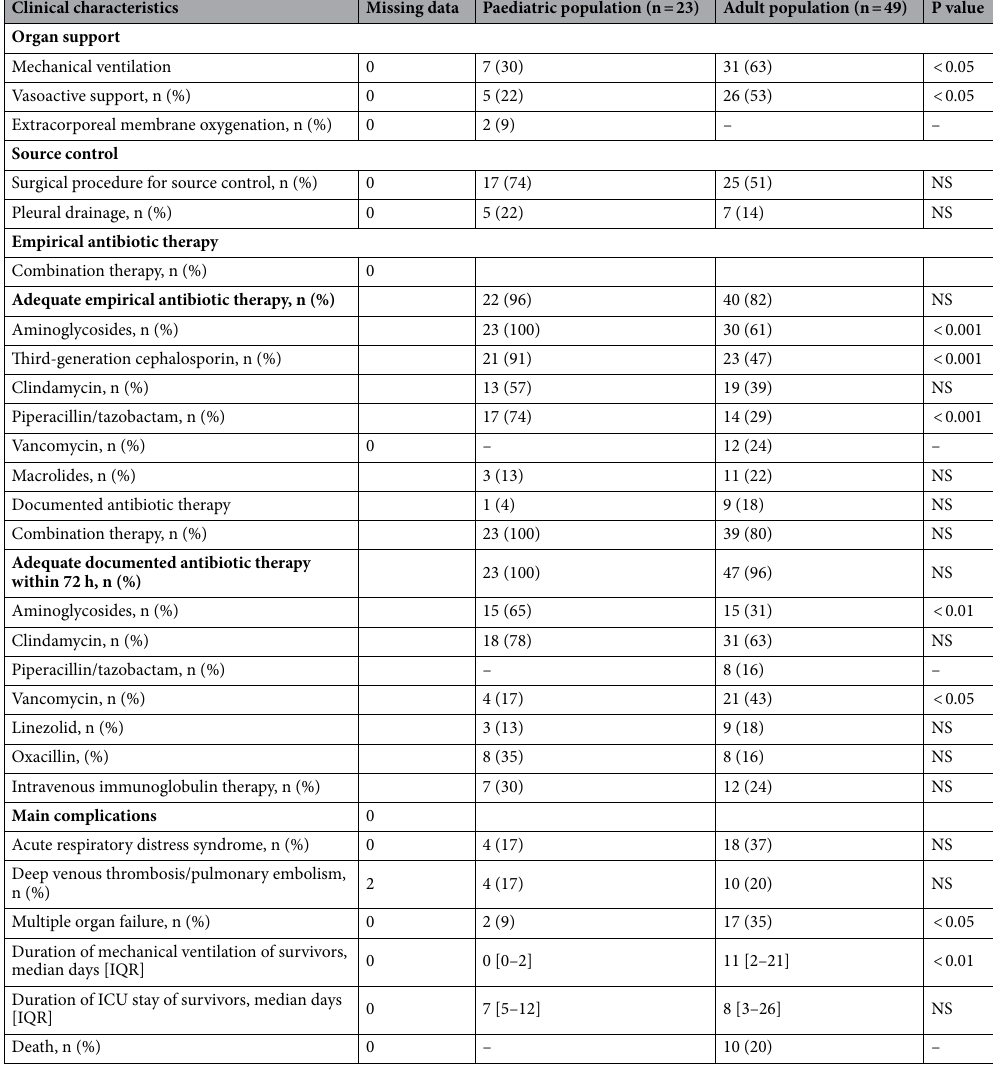
Table 2. ICU management and